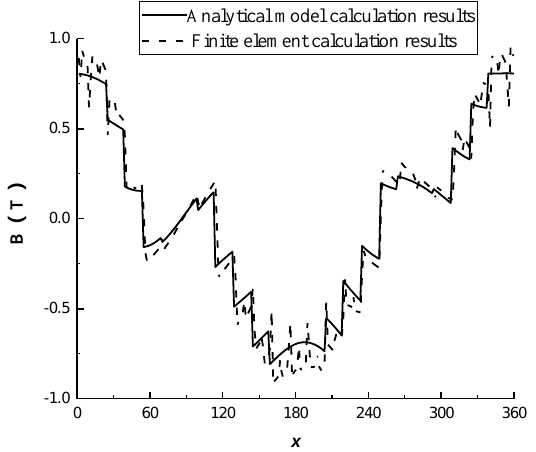
Energies 2017 , 10 , 732 Figure 10. The flux density distribution of air gap in fault. Figure 10. The flux density distribution of air gap in fault.